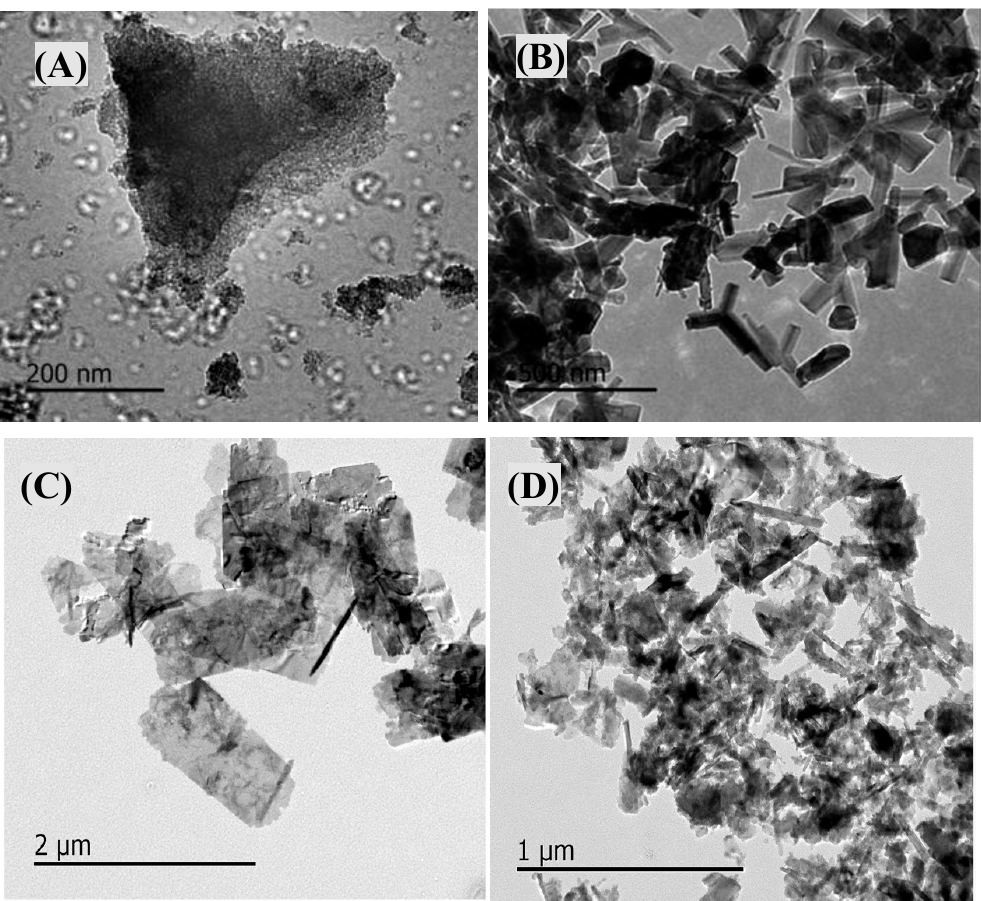
Figure 3. Transmission electron microscope images of ferrihydrite before and after reaction for 60 days in Fe(II)-induced phase transformation: ( A ) ferrihydrite before reaction; ( B ) after the Fe(II)-induced reaction without effects of Ln(III); ( C ) after the Fe(II)-induced reaction with La(III); and ( D ) after the Fe(II)-induced reaction with Ho(III). Reprinted with permission from Ref. [5]. Copyright 2016